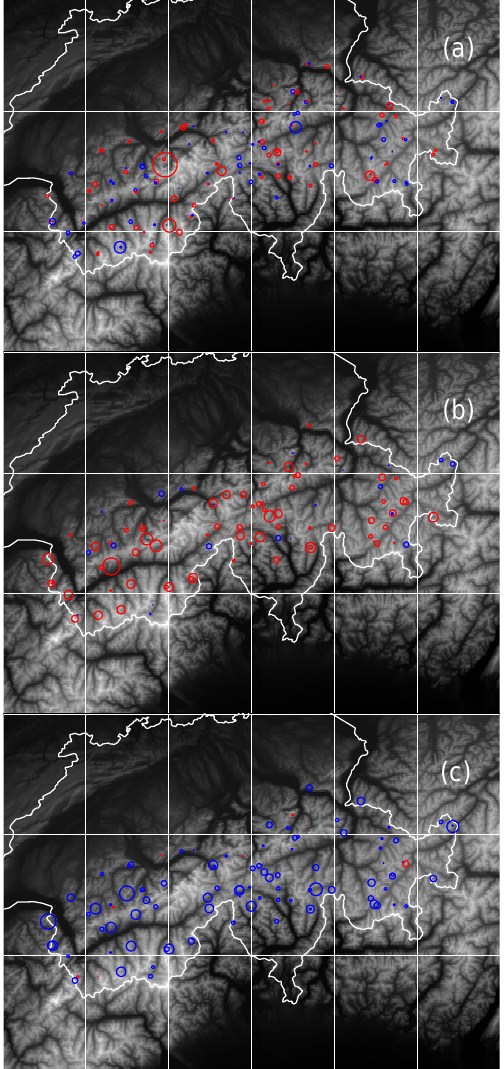
Figure 9. Distribution of bias in (a) TAIR, (b) GST and (c) SD at the macroclimatic scale. Blue indicates negative bias (model colder/less); red indicates positive bias (model warmer/more). Size of circle indicates the relative magnitude. Sites correspond to all IMIS stations included in the